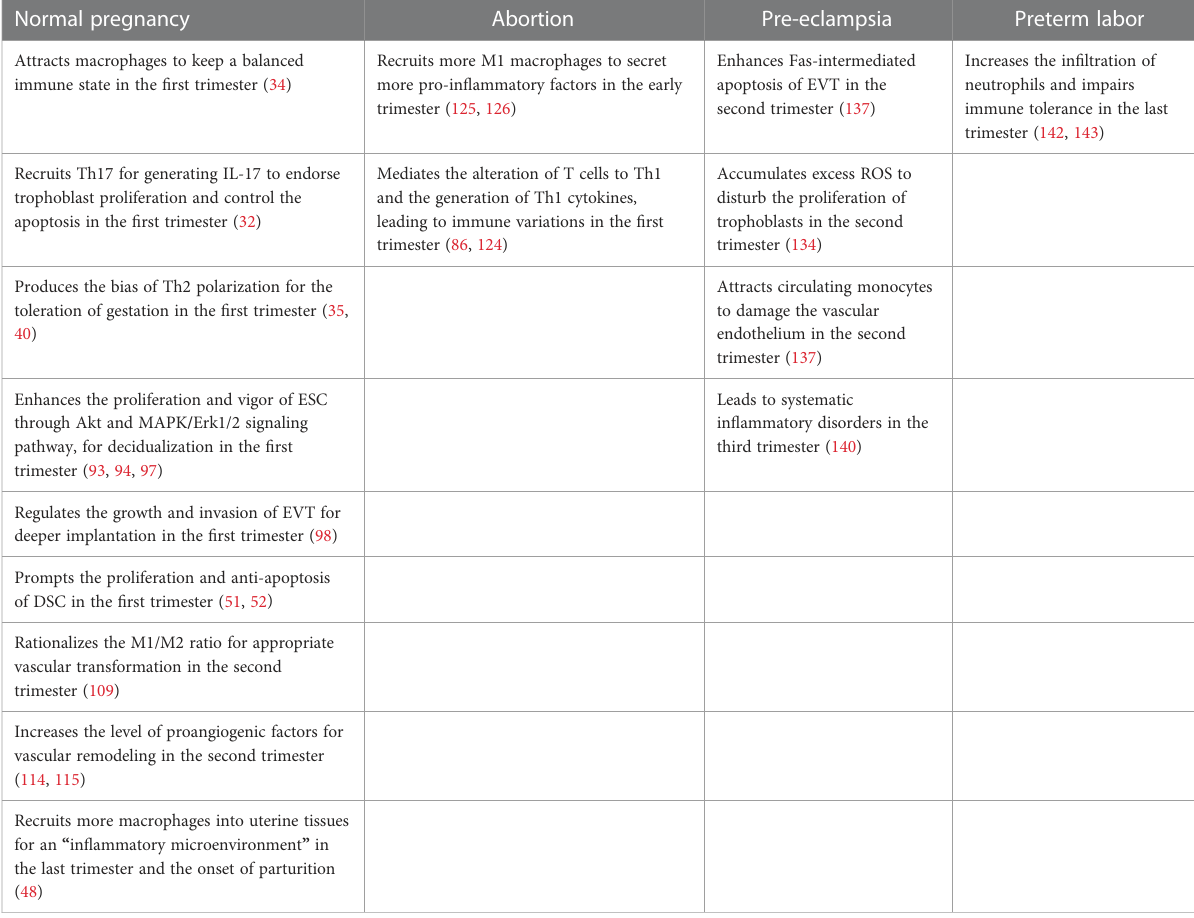
TABLE 3 The behaviors of CCL2 in different pregnancy outcomes at speci fi c trimesters . Normal